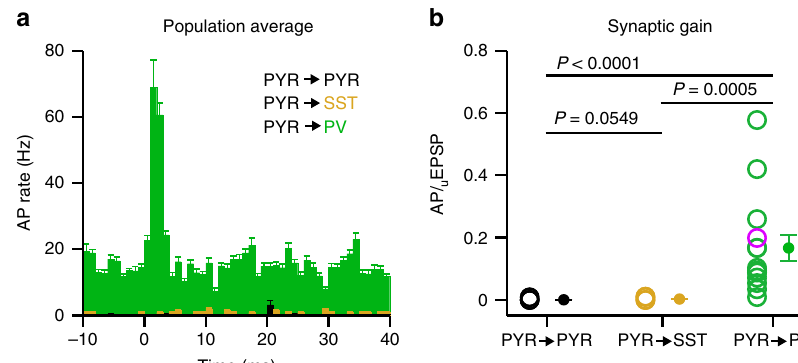
Fig. 3 Parvalbumin-expressing GABA-ergic neurons have a higher excitatory synaptic gain. a Population peri-stimulus time histogram of the responses of PYR neurons (black, n = 35 neurons), SST neurons (orange, n = 7 neurons) and PV neurons (green, n = 14 neurons) to evoked single PYR neuron APs during UPstate. PSTHs show the robust recruitment of PV neurons by evoked PYR neuron APs. b The synaptic gain (number of additional APs/PYR AP) is higher in PV neurons (green) than in PYR neurons (black) and SST neurons (orange). Open circles represent single connection, purple circle shows connection in an awake mouse, fi lled circle with error bars shows mean ±